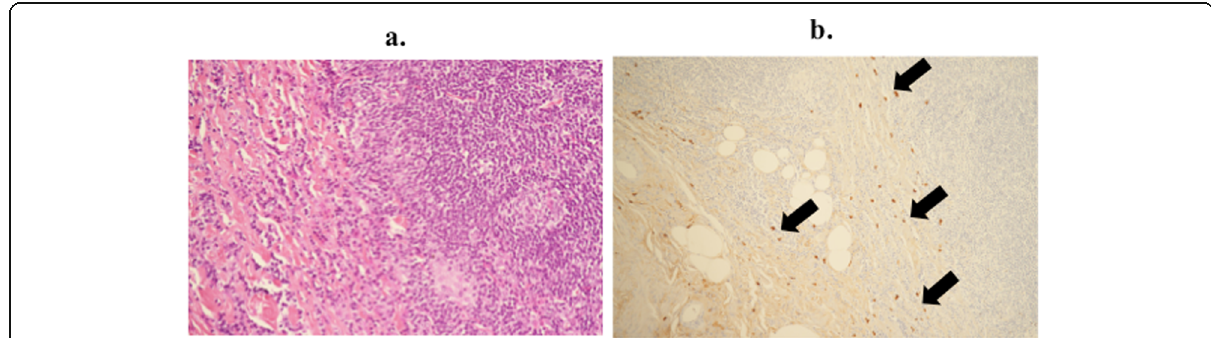
Fig. 5 Histopathological findings. a Hematoxylin and eosin staining showed abundant infiltration of lymphocytes with lymphoid follicles around the left ureter and peripheral proliferation of collagenous fibers (× 200). b Immunohistochemical staining showed that the mean IgG4-positive plasma cell count was 50 per high-power field, and the ratio of IgG4-positive/IgG-positive cells was 54% (IgG4, immunoperoxidase, × 100;